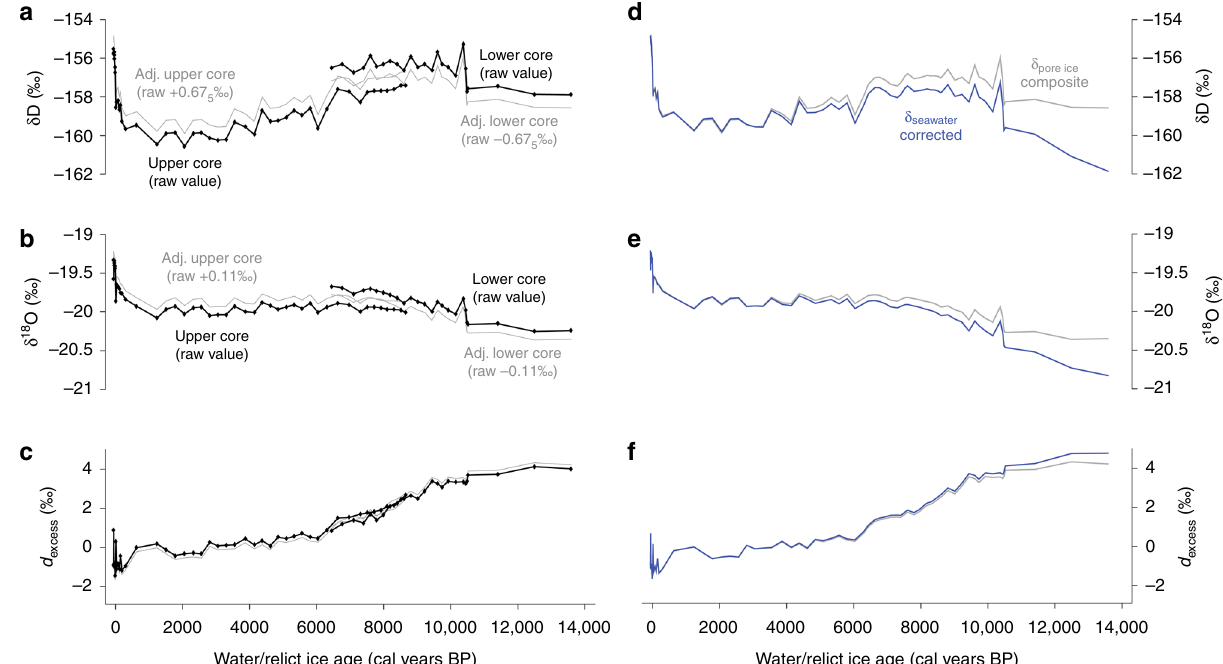
Fig. 2 Holocene pore ice record. a – c Comparison of raw δ D, δ 18 O and d excess pore ice series (black lines) from the upper vs. lower cores, and ‘ adjusted ’ δ D, δ 18 O and d δ D and δ 18 O between the upper and lower cores during the excess series (grey lines), which are each corrected by half of the mean offsets in period of overlap; d – f Composite pore ice δ D, δ 18 O and d excess (grey lines), and δ seawater -corrected pore ice records (blue